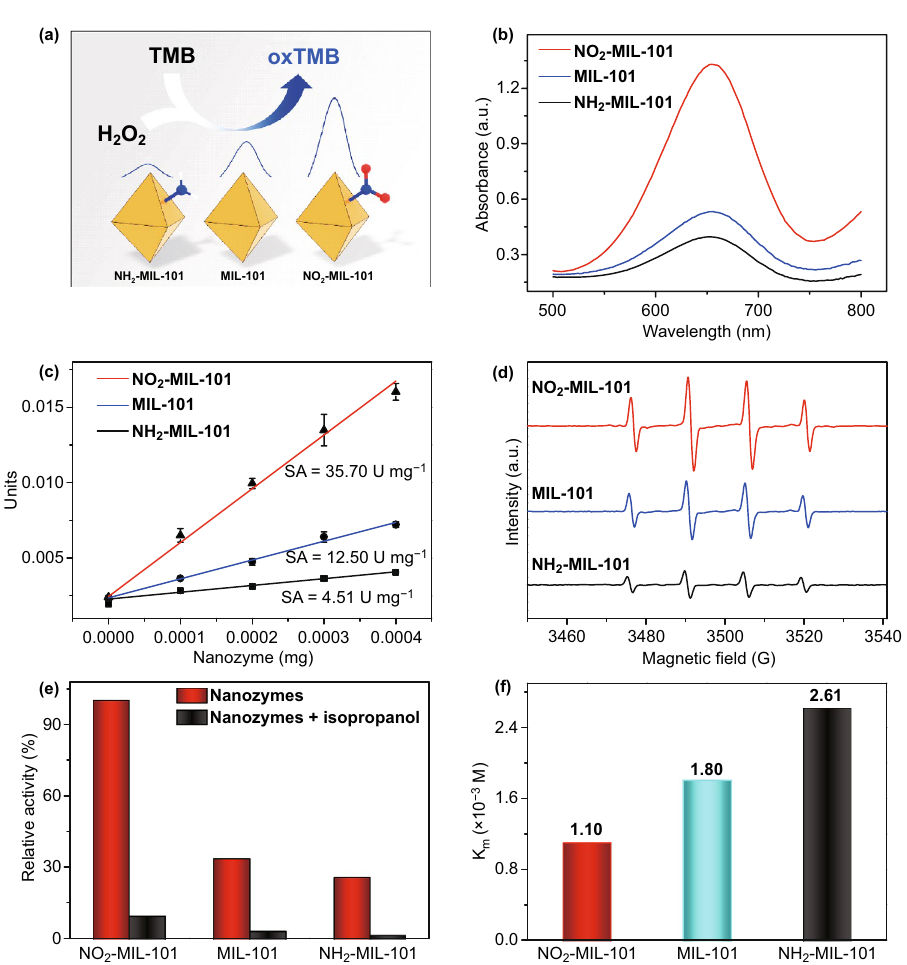
Fig. 2 a Schematic diagram of the MOF-based nanozymes to mimic POD. b Absorption spectra of TMB catalyzed by the different nanozymes in the system containing H 2 O 2 and HAc-NaAc (pH = 3.0). c Specific activities of nanozymes. d EPR spectra of different nanozymes in the sys- tem containing H 2 O 2 , 5,5-dimethyl-1-pyrroline 1-oxide (DMPO) and HAc-NaAc (pH = 3.0). e Relative activity of nanozymes in the presence and absence of isopropanol. f K m of nanozymes for H 2 O